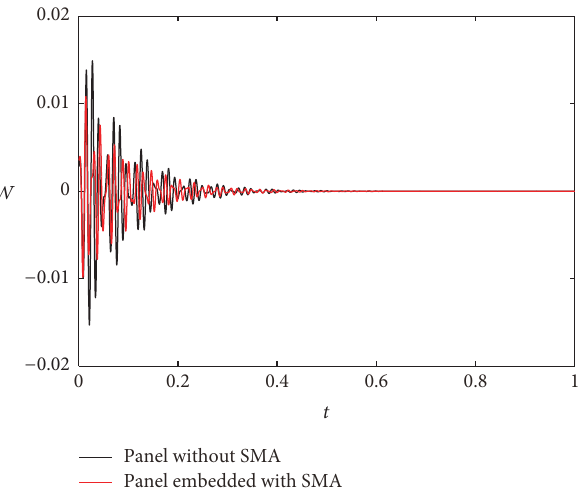
Figure 8: Natural frequencies versus dynamic pressure under different temperature variations and volume fraction of SMA wires.